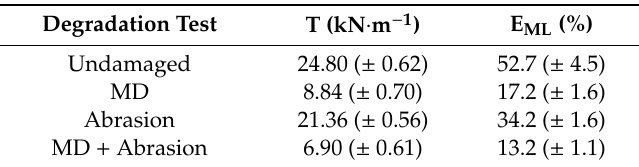
Table 2. Tensile properties of the woven geotextile W180.